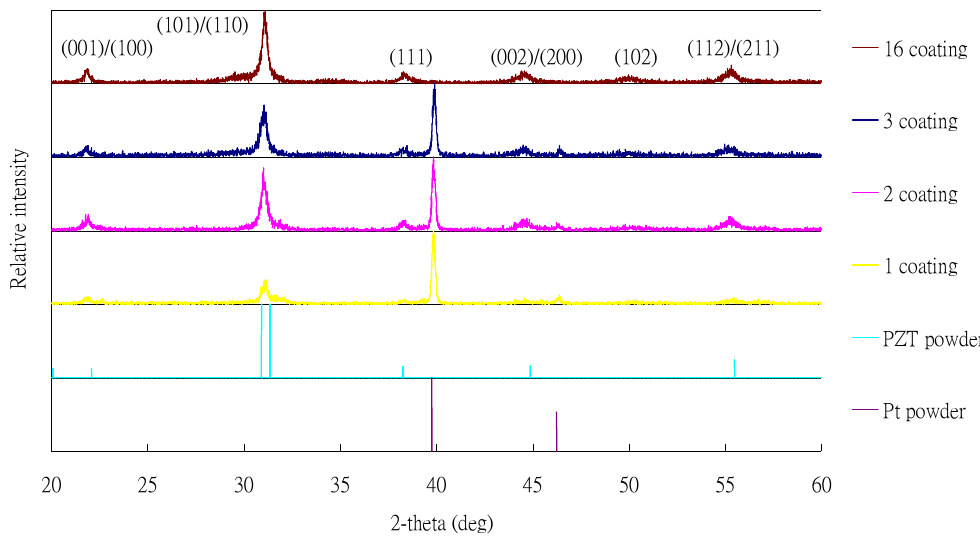
Figure 2. XRD spectra of PZT powder, Pt and PZT films with one, two, three and 16 coating layers.